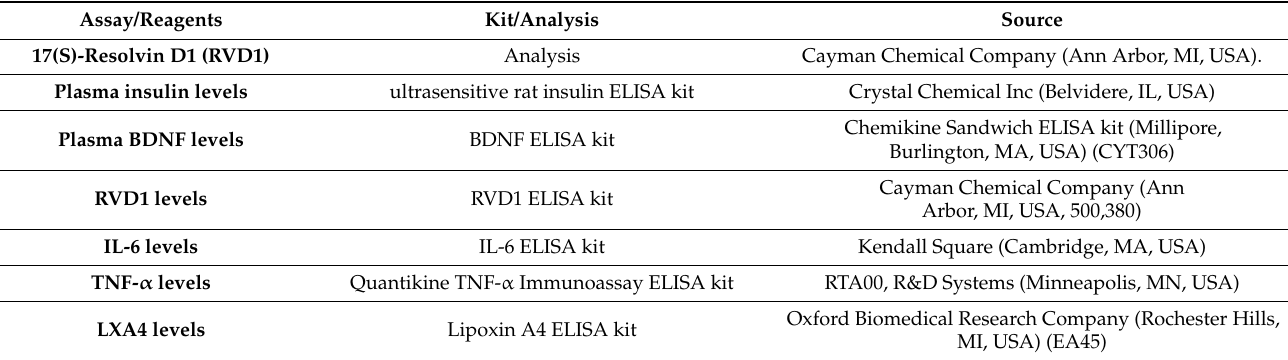
Table 2. Chemicals/kits and reagents along with source used in this in vivo